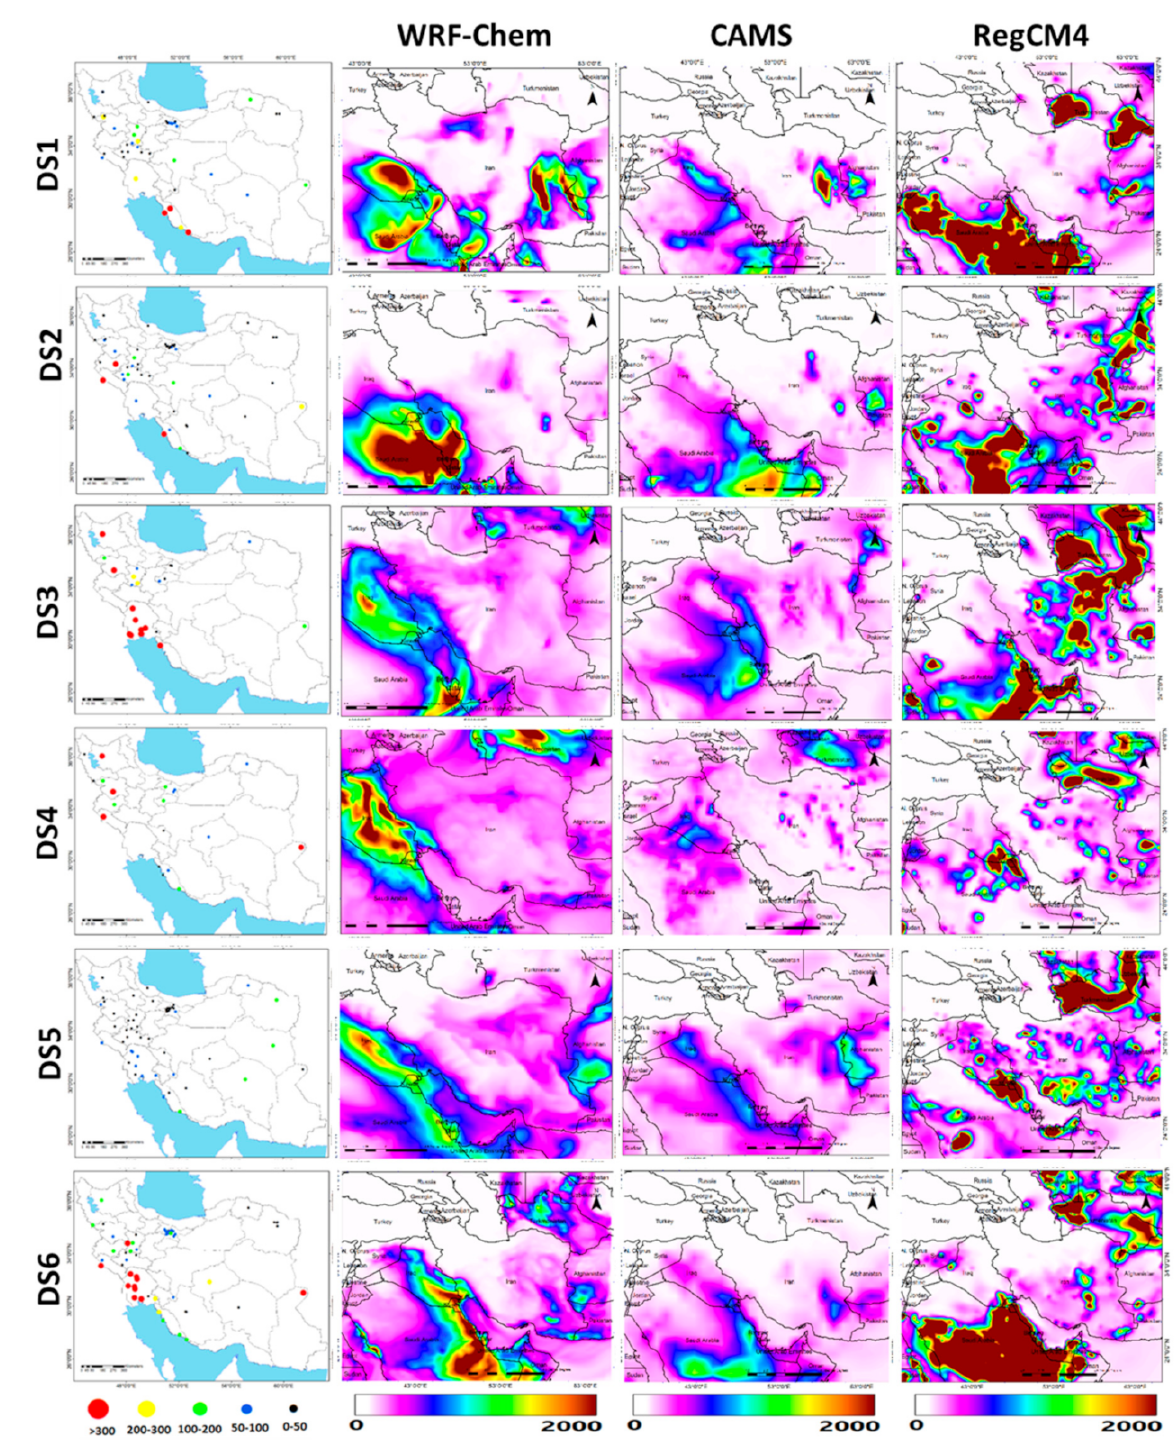
Figure 5. PM 10 concentrations ( µ g m − 3 ) from air quality monitoring stations in Iran for each DS event at 12:00 UTC (left column). PM 10 concentrations from WRF-Chem, CAMS and RegCM4 simulations at 12:00 UTC on 18 February 2017 (DS1), 3 February 2017 (DS2), 20 January 2018 (DS3), 29 October 2017(DS4), 30 September 2016 (DS5), 10 December 2016 (DS6). [LST = UTC +